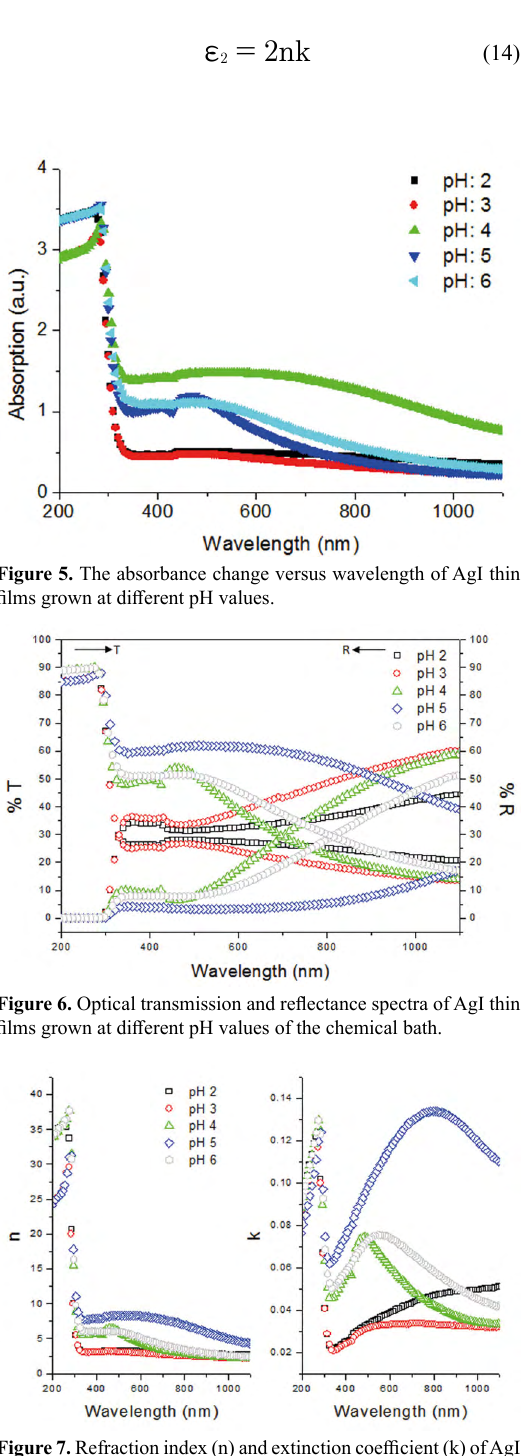
Figure 7. Refraction index (n) and extinction coefficient (k) of AgI thin films grown at different pH values.